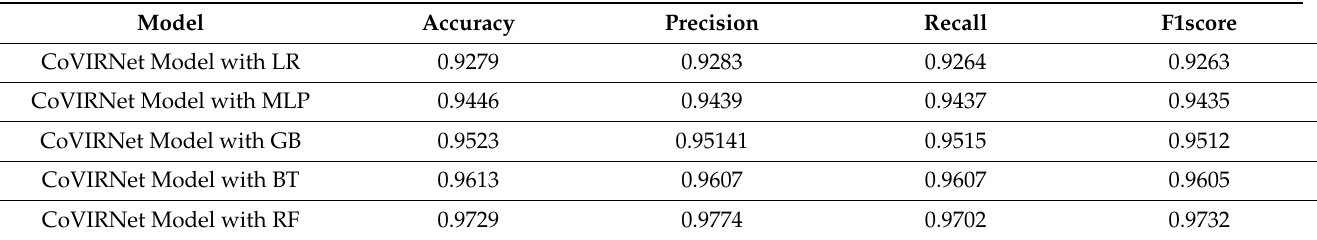
Figure 8. ( a ) ROC for proposed deep-learning model with and without feature extraction compared with an existing deep- learning model. ( b ) Precision–recall curves for proposed model compared with existing state-of-the-art deep-learning models. Table 3. Performance analysis of deep-learning and machine-learning model. Feature extracted from deep-learning proposed model and classify with machine-learning